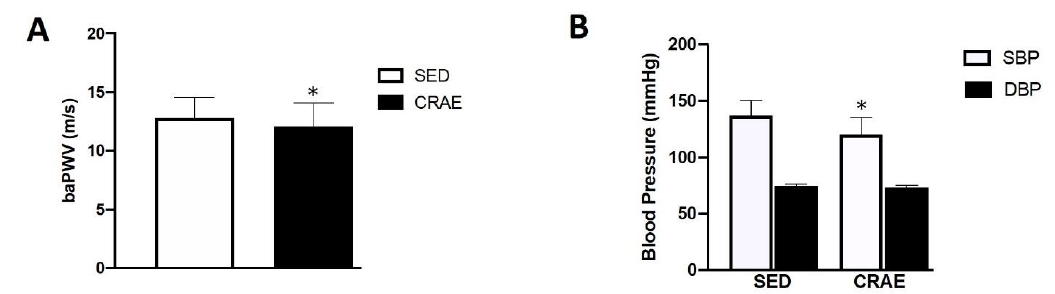
Figure 2. Differences in brachial-to-ankle pulse wave velocity (baPWV) and blood pressure (BP) between the combined resistance and aerobic exercise training (CRAE) and the sedentary (SED) groups. ( A ) The CRAE group had significantly lower baPWV (m/s) compared to the SED group (12.8 ± 1.8 vs. 12.1 ± 2.0 m/s, SED vs. CRAE, respectively; p = 0.041) ( B ) The CRAE group had significantly lower systolic BP (SBP) compared to the SED group (137.0 ± 33.0 vs. 120.0 ± 15.0 mmHg, SED vs. CRAE, respectively; p = 0.03). There were no differences in diastolic BP (DBP) between groups (68.0 ± 15.0 vs. 67.7 ± 10.0 mmHg, SED vs. CRAE, respectively; p = 0.12). Values are Mean ± SD. * p < 0.05 vs. SED.